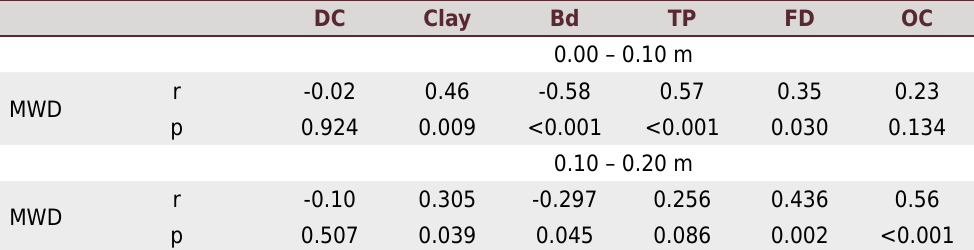
Table 3. Coefficient of correlation (r) and probability (p) between the mean weight diameter (MWD) and the soil physical properties of a Typic Hapludult at the 0.00-0.10 and 0.10-0.20 m layers